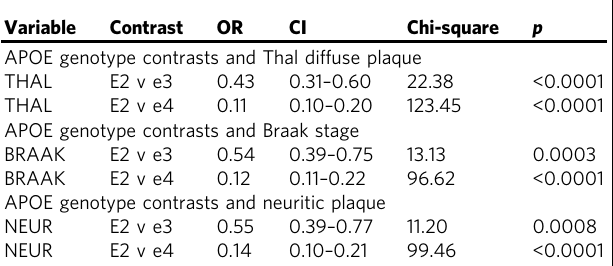
Table 1 APOE logistic regression analysis for AD neuropathologies.